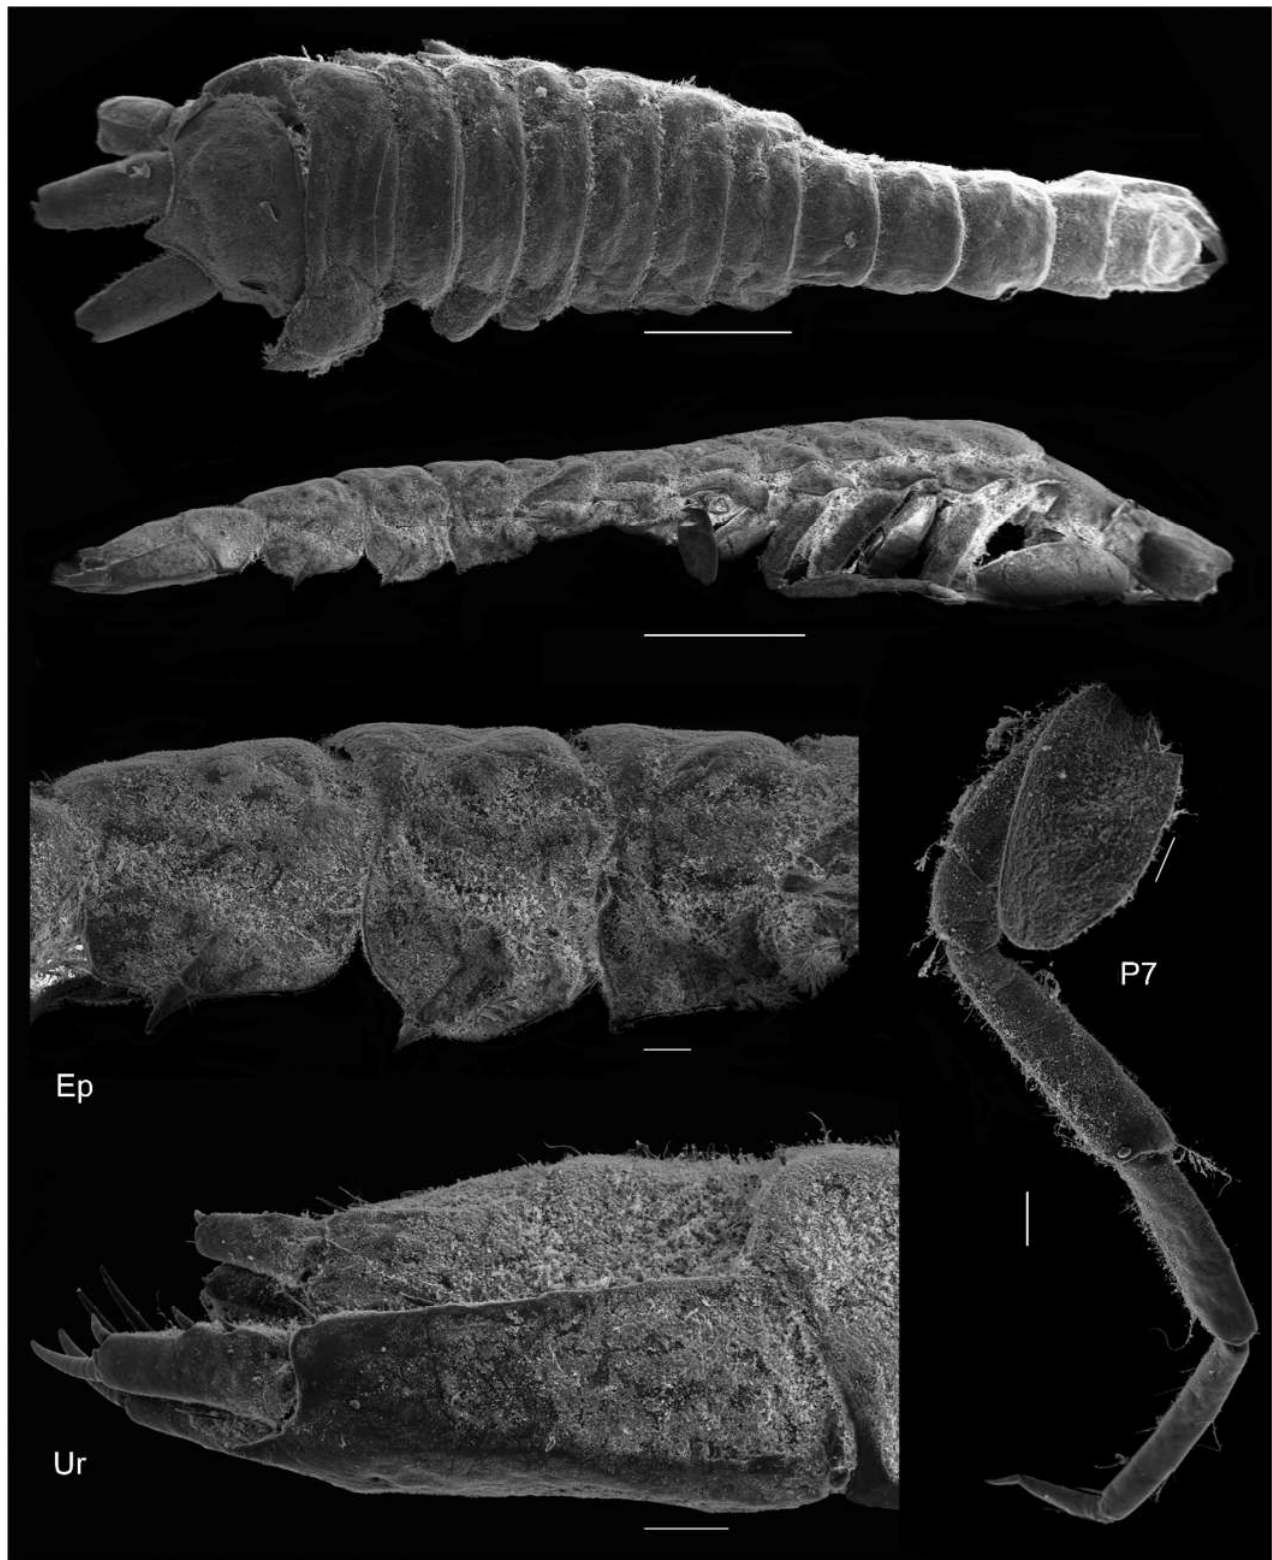
Figure 7. Unciola conchicola sp. nov. SEM image, paratype male, 7 mm, ZMHK-56724, South Island, Iceland Basin, 1921 m. Scales: habitus 1 mm, urosomites, uropod and pereopod 7 0.1mm.